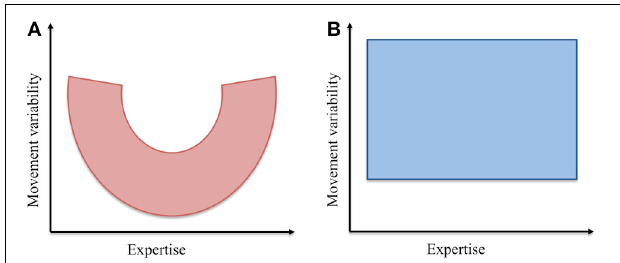
FIGURE 9 | Schematic representations of the hypothesized and the observed relationships between movement variability and expertise.